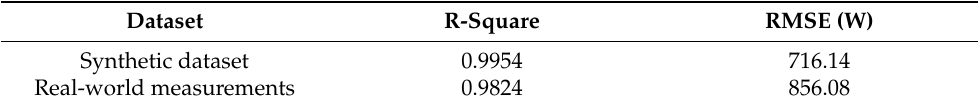
Figure 11. Battery power as a function of mechanical power in acceleration mode. Table 6. Performance of elaborated model on both